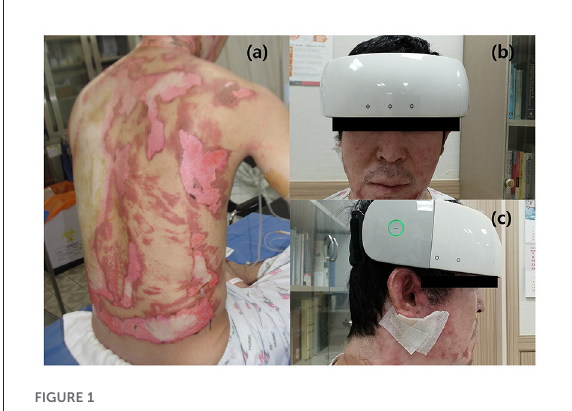
FIGURE1 fNIRS device used in patients with electrical burns. (a) A patient with electrical burn injury. (b,c) Anterior (b) and lateral (c) views of a patient with electrical burn injury wearing the fNIRS device. (c) Cerebral hemodynamics were observed during the HUT using the fNIRS device attached to the frontotemporal area. fNIRS, functional near-infrared spectroscopy; HUT, head-up tilt table test. Patient informed consent was obtained for the use of personally identifiable photos for